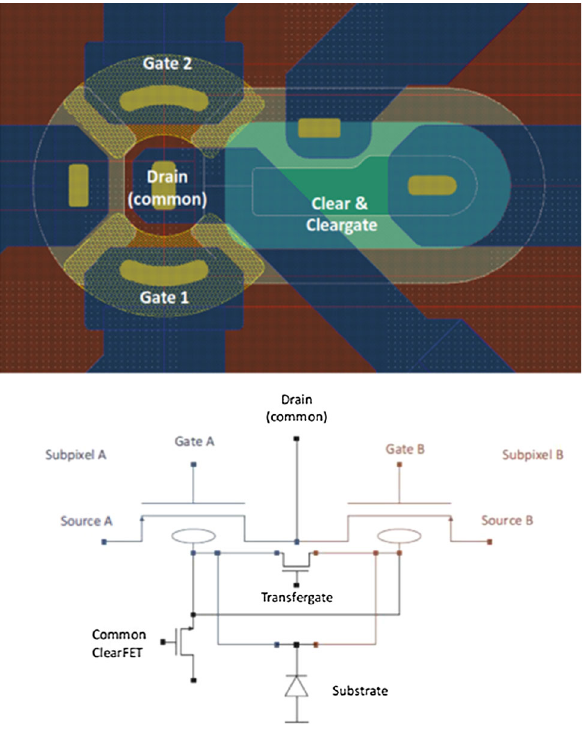
Fig. 6 Compact RNDR DEPFET superpixel layout in circular geom- etry as operated for the prototype tests (top) and equivalent circuit rep- resentation (bottom)